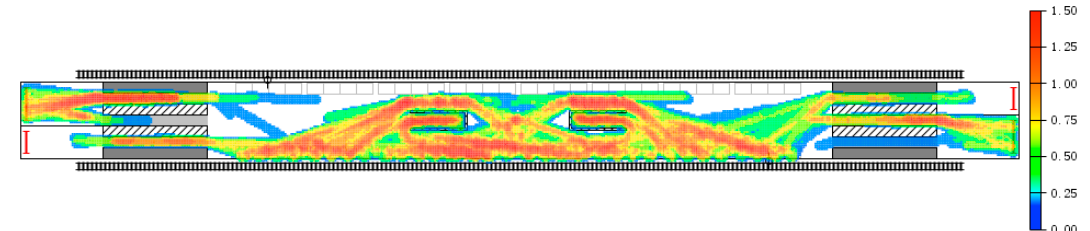
Figure 18. Passenger activity interface.